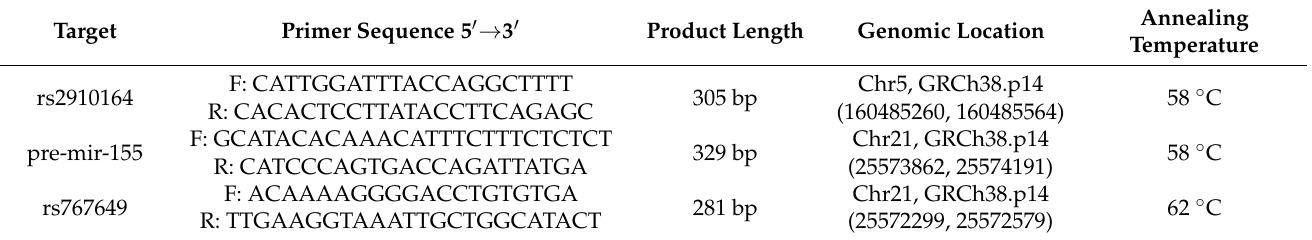
Table 4. Primers and conditions for PCR, size and genomic location of the